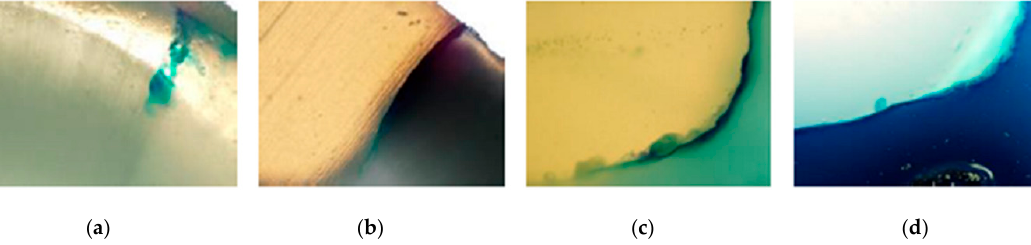
Figure 6. Samples of microleakage in ideal surface cavity conditions: ( a ) Dentsply “Prime and Bond Active”, ( b ) Coltene “One Coat 7 Universal”, ( c ) 3M ESPE “Single bond”, and ( d ) Kuraray “Clearfil Universal Bond Quick”.